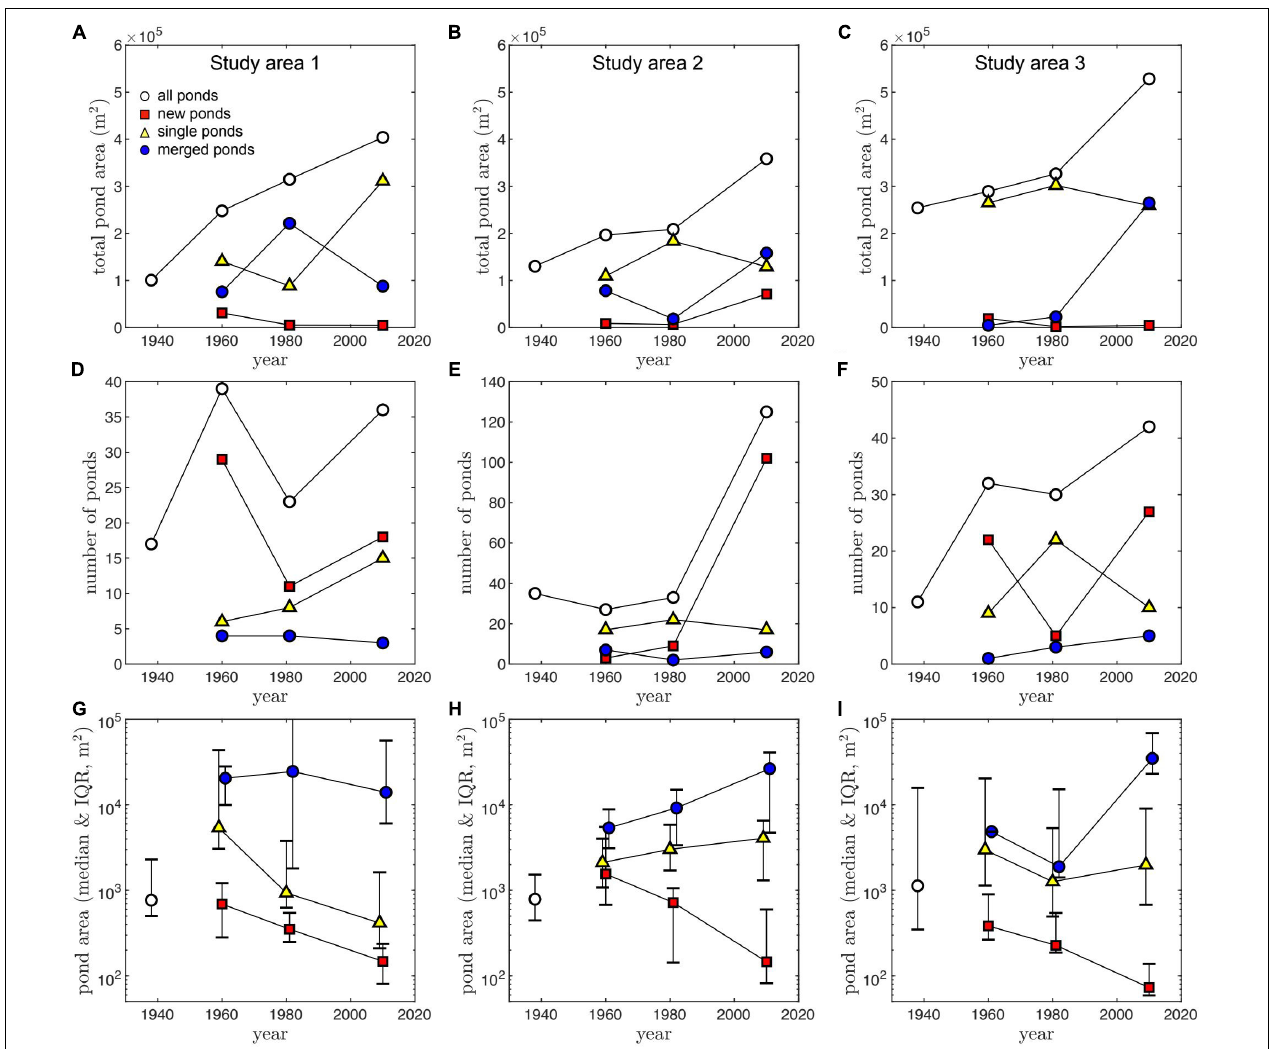
FIGURE 3 | Total pond area (A–C) , number of ponds greater than 50 m 2 (D–F) , and individual pond area (G–I) , as function of time and pond type, for the three study areas (columns). Due to the skewed distribution of individual pond areas, data points represent the median value, and error bars represent the Interquartile range (IQR), defined as the difference between the 75th and the 25th